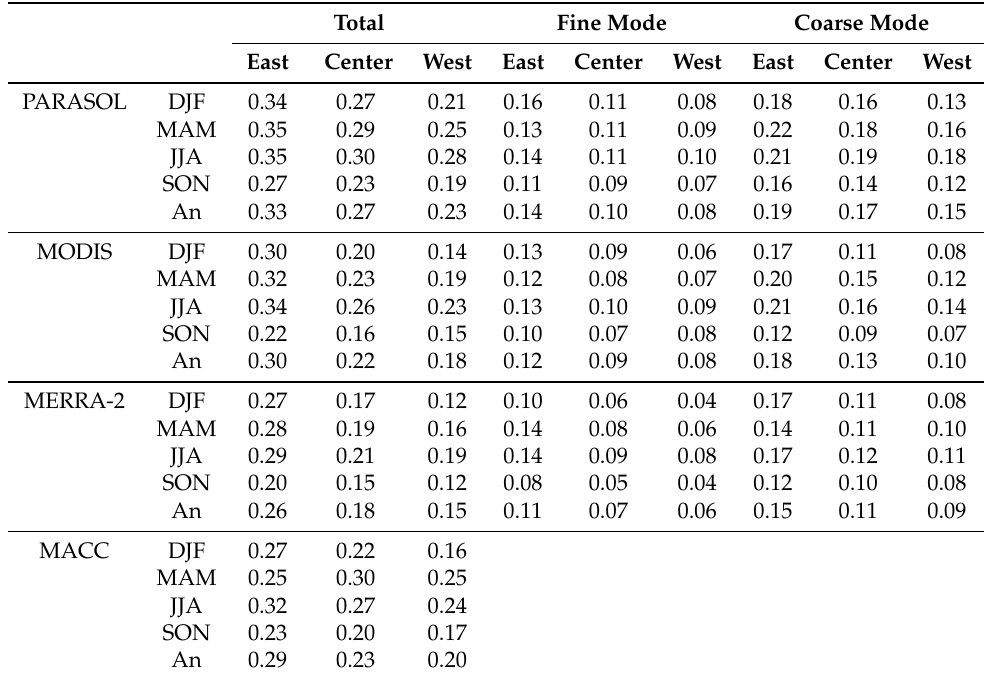
Table 3. Total AOD, AOD f , AOD c at 550 nm from PARASOL observations, MODIS observations, MERRA-2 reanalysis and MACC reanalysis averaged from 2005 to 2013. Total Fine Mode Coarse Mode East Center